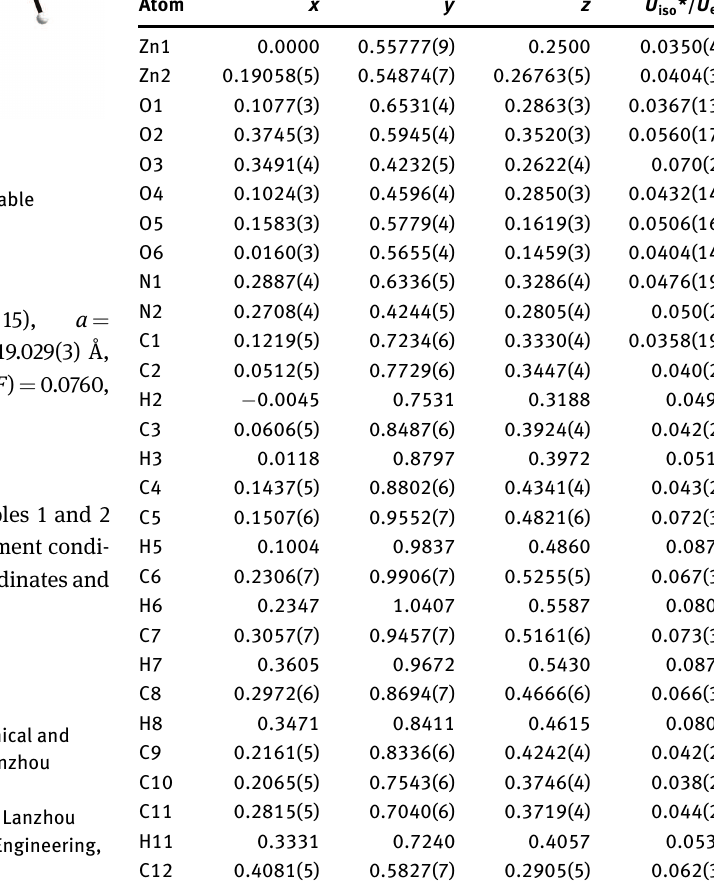
Table 2: Fractional atomic coordinates and isotropic or equivalent isotropic displacement parameters (Å 2